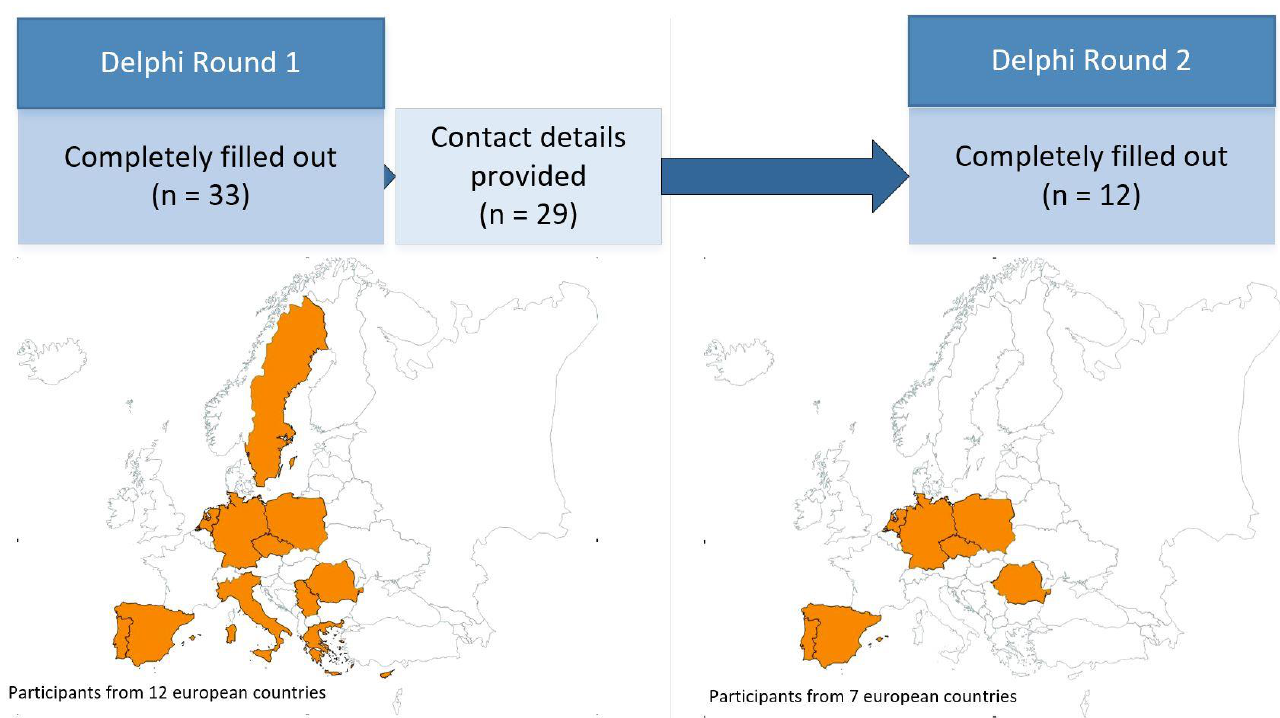
Figure 3. Presentation of the number of participants in the two Delphi survey rounds from the European countries involved.